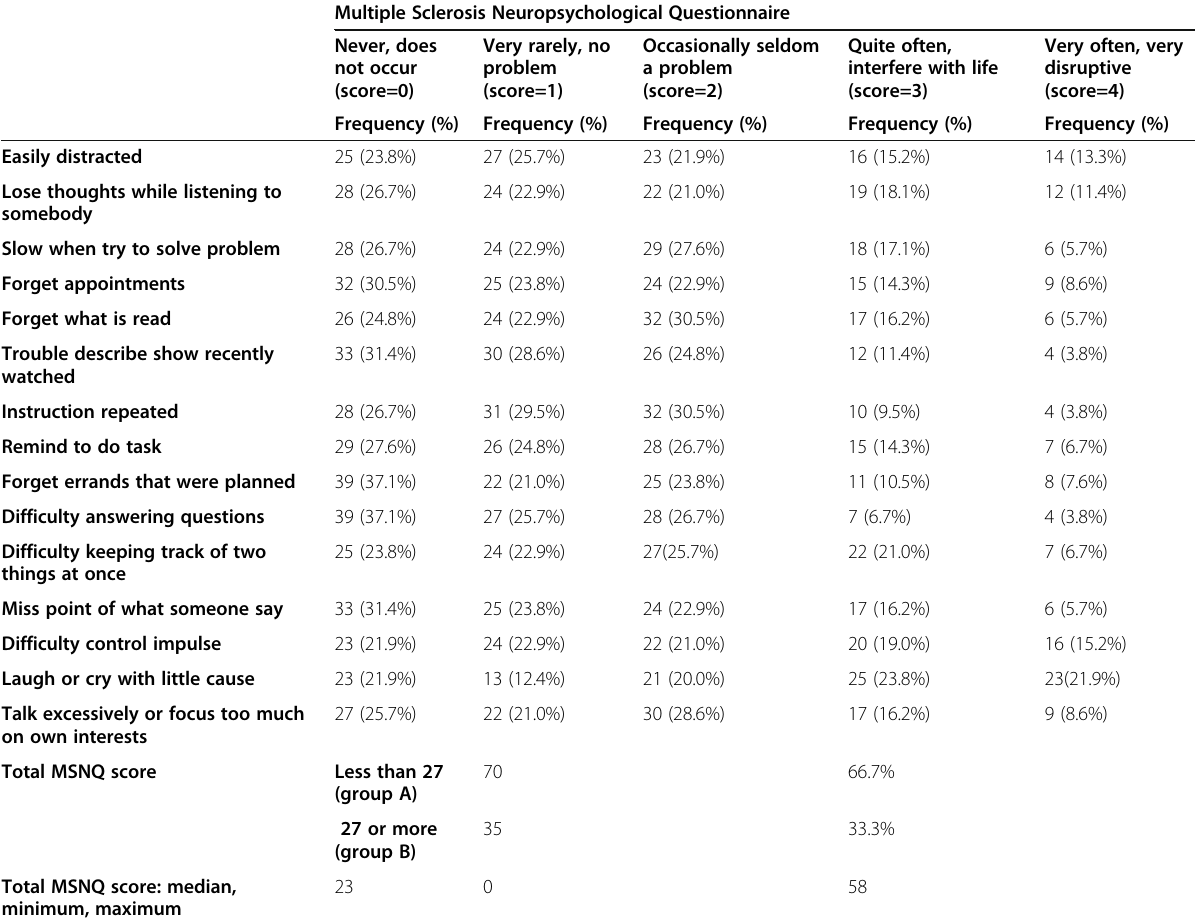
Table 3 Multiple Sclerosis Neuropsychological Questionnaire (MSNQ) Multiple Sclerosis Neuropsychological